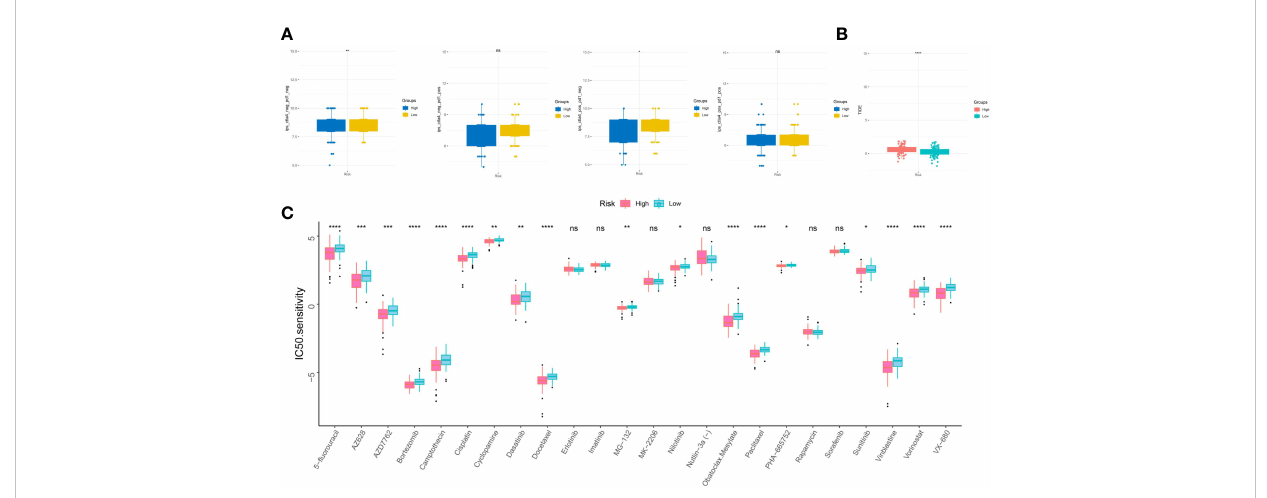
FIGURE 9 Sensitivity to drugs in virus-related HCC patients with different in fl ammation-related risk score subgroups. (A) immunophenotype score (IPS) and (B) tumor immune dysfunction and exclusion (TIDE) in different IRG score groups. (C) Relationships between IRG and chemotherapeutic sensitivity. *p < 0.05, **p < 0.01, ***p < 0.001, ****p < 0.0001, ns, not signi fi